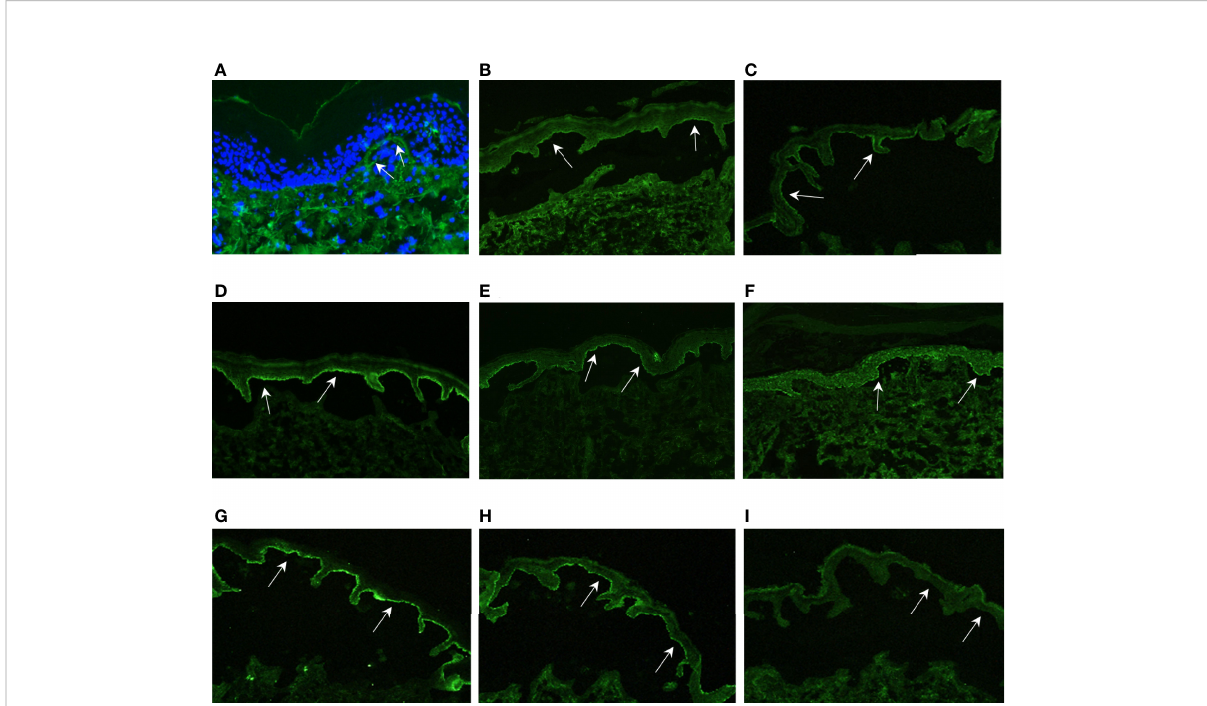
FIGURE 3 Immuno fl uorescence results. (A) DIF of patient 1 shows discrete linear deposition of IgG at the DEJ (white arrows); (B – F) : ss-IIF show IgG staining on the epidermal side of the split, indicated by white arrows (B) = Pat. 1, (C) = Pat. 2, (D) = Pat. 3, (E) = Pat. 4, (F) = Pat. 5); (G) ss-IIF IgA shows IgA staining on the epidermal side of the split (white arrows) ; (H) ss-IIF IgG positive control with IgG staining on the epidermal side of the split, indicated by white arrows; (I) ss-IIF IgG negative control without IgG staining on the epidermal side of the split, indicated by white arrows. The IgA positive control was comparable to the staining in (H) (not